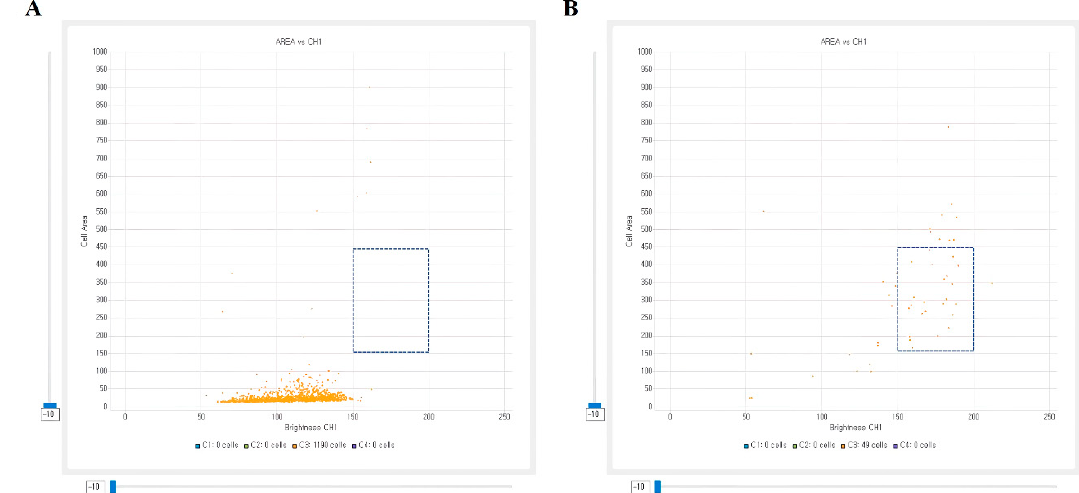
Figure 3. Scatter plots illustrating parasite signal area and SYBR green I intensity level of P. falciparum positive sample ( A ) and P. vivax -infected patient sample by automatic malaria parasite detection system ( B ). The Cell Area refers to area in pixels and Brightness CH1 refers to signal intensity of SYBR green I. P. vivax shows more different parasite developmental stages, such as trophozoites, with lager area and higher intensity compared to that of P. falciparum.